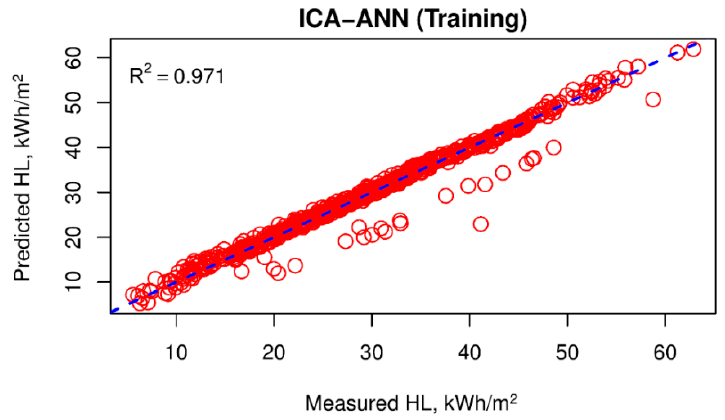
Figure 16. HL predictions on the training dataset of the ICA-ANN model.